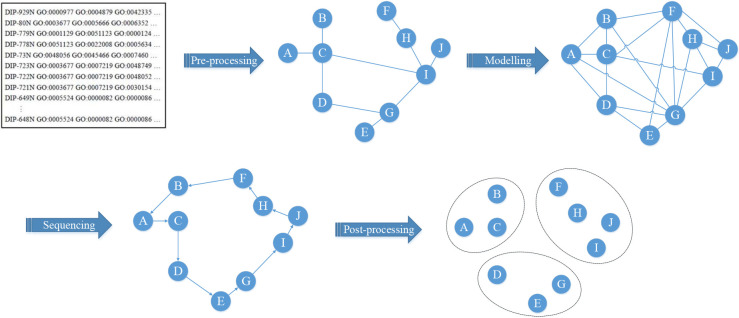
Main stages of LKHM.